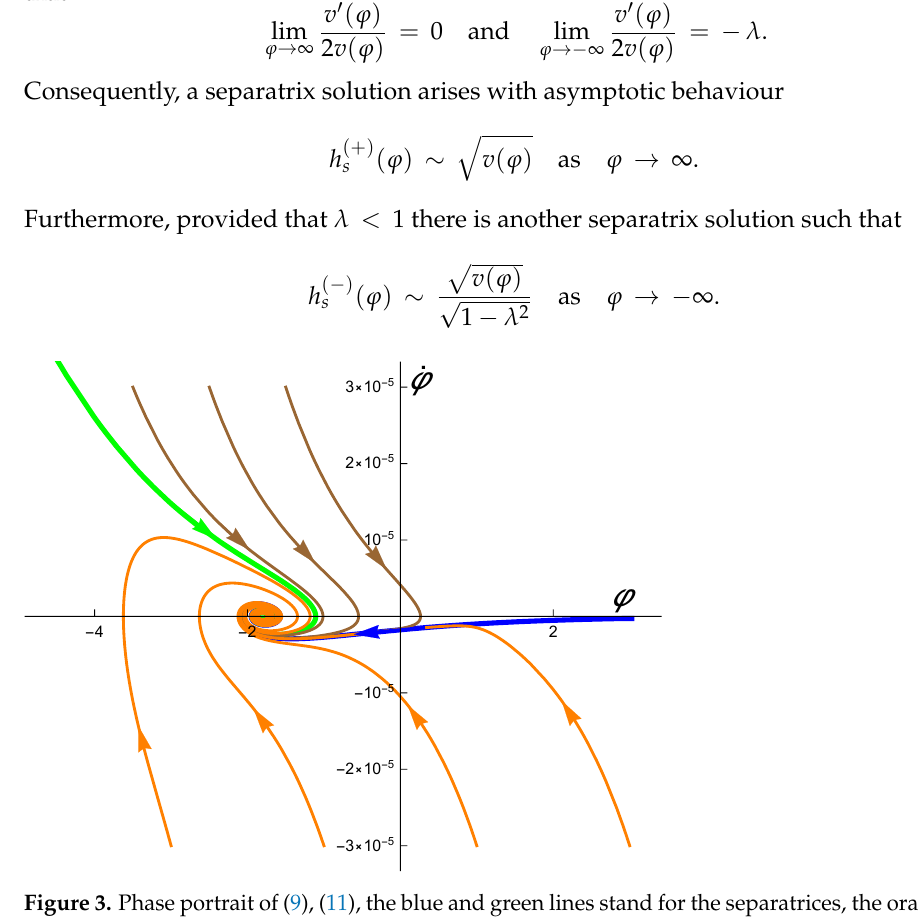
√ √ 3 2 , µ = , c 1 = 2 × 10 − 10 , 3 4